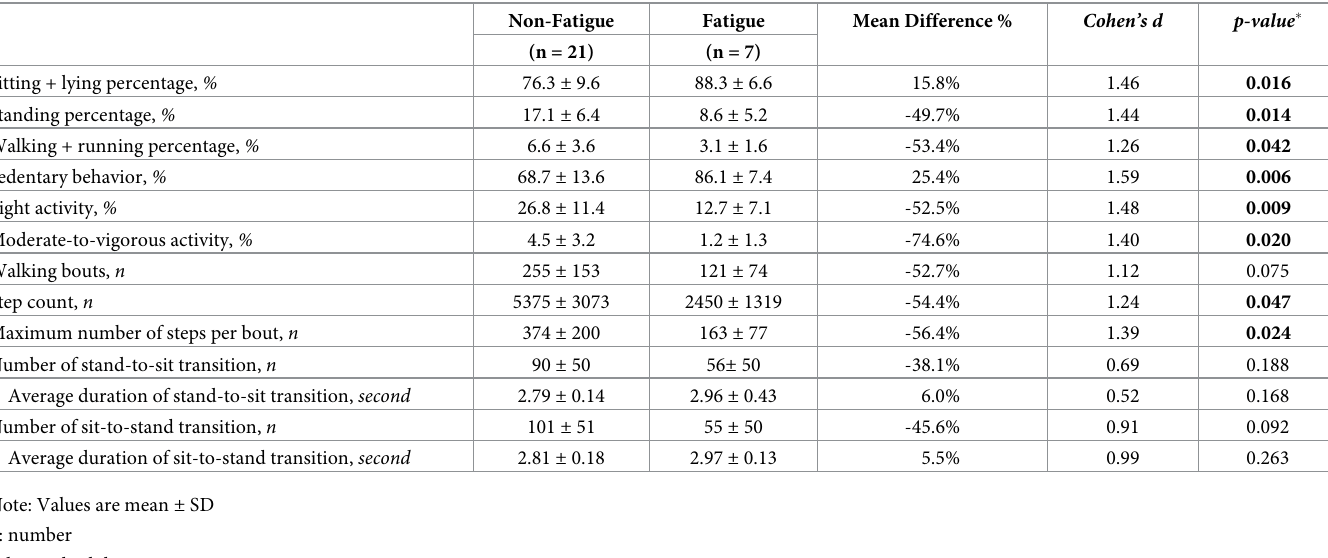
Table 3. Between-group comparison for daily physical activity.